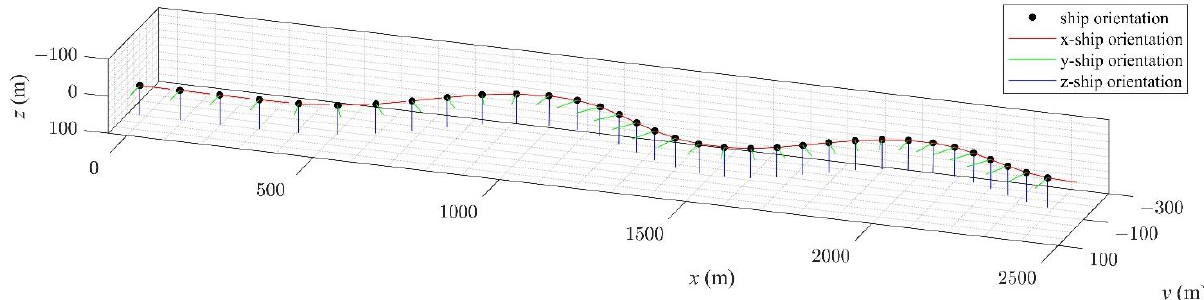
Figure 7. Time series of simulated ship poses.